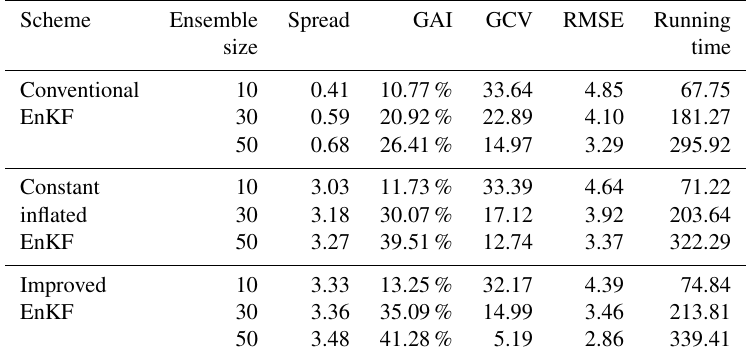
Table 2. Same as in Table 1 but for 20 observations.